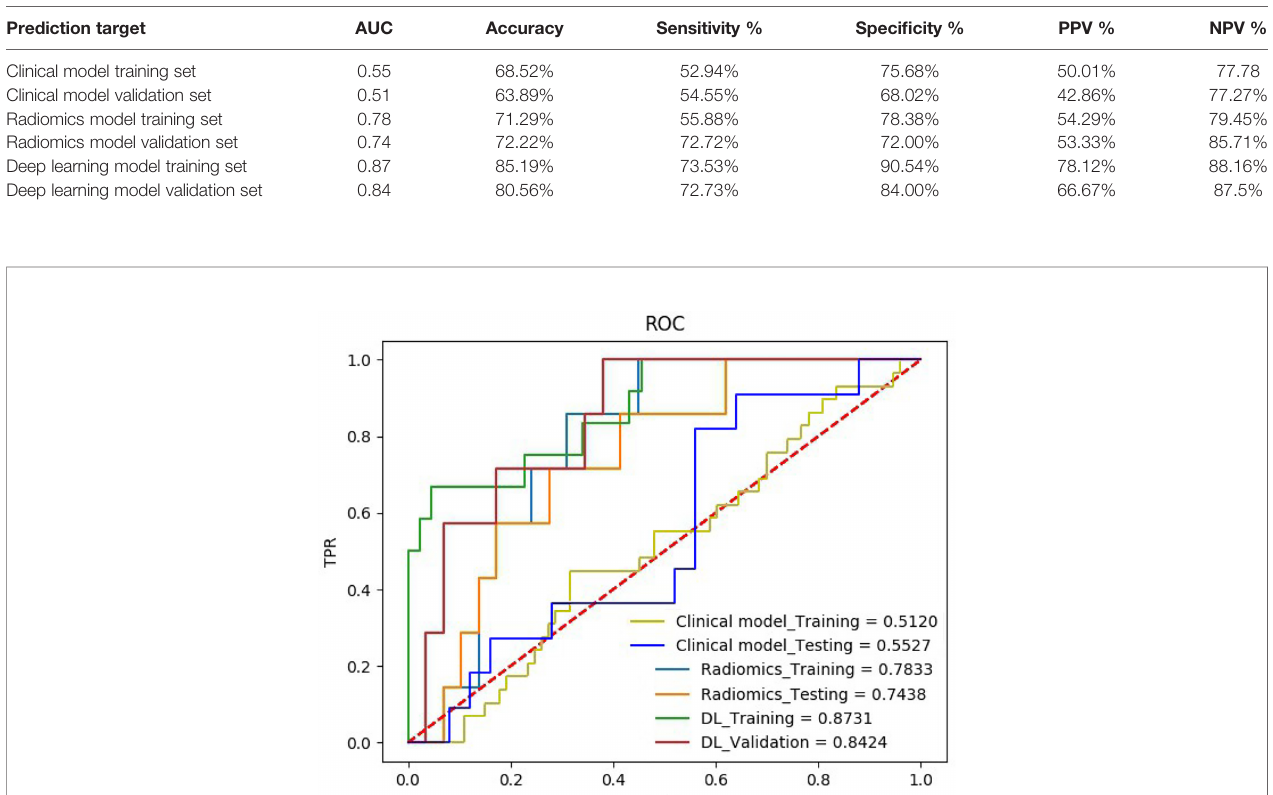
TABLE 2 | Predictive performance of each model for